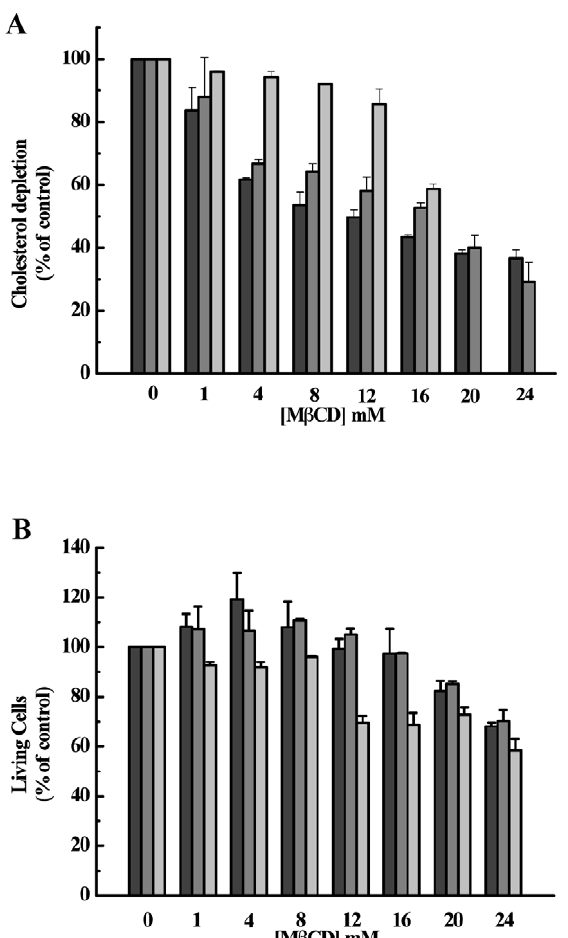
Figure 1. Effect of M b CD on cell viability. (A) Cholesterol depletion. Cells were pre-treated with M b CD for 30 min at 37 u C, and cholesterol content was quantified as described in Experimental Procedures. (B) Cell viability. Cells were incubated with M b CD for 30 min at 37 u C. Then MTT reagent was added and incubated for 4 h. The cells were incubated overnight with the solubilization buffer. Absorbance was measured at 570 nm. The bars represent BHK-21, VERO and C636, respectively from left to right.